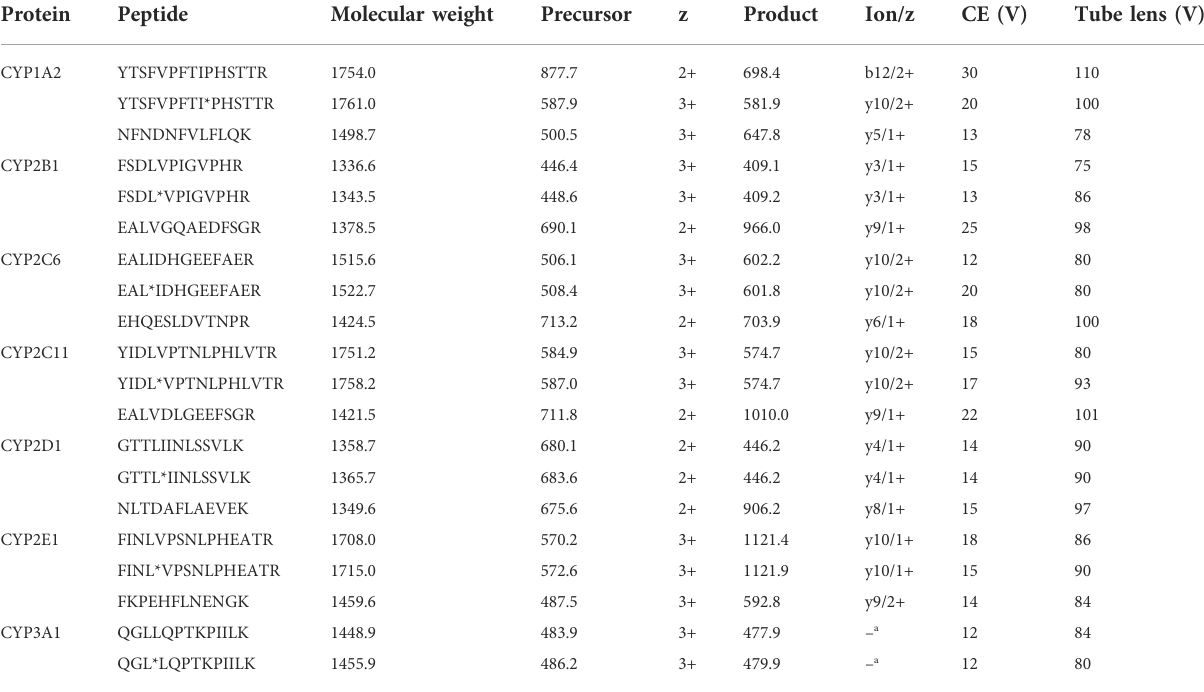
TABLE 1 Overview of surrogate peptides and their respective ions and mass transitions used for CYP enzyme quanti fi cation ( a isotope-labeled amino acid). Protein Peptide Molecular